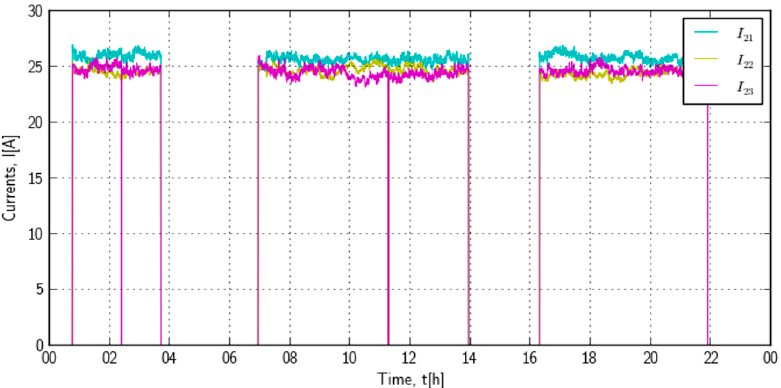
Figure 3. The diagrams of the phase and line voltage changes U(t) at PS Knez Selo on 30 December 2009.